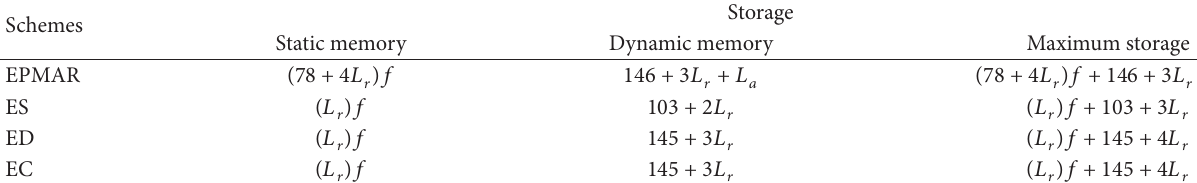
Table 4: Storage analysis of card reader (bytes).